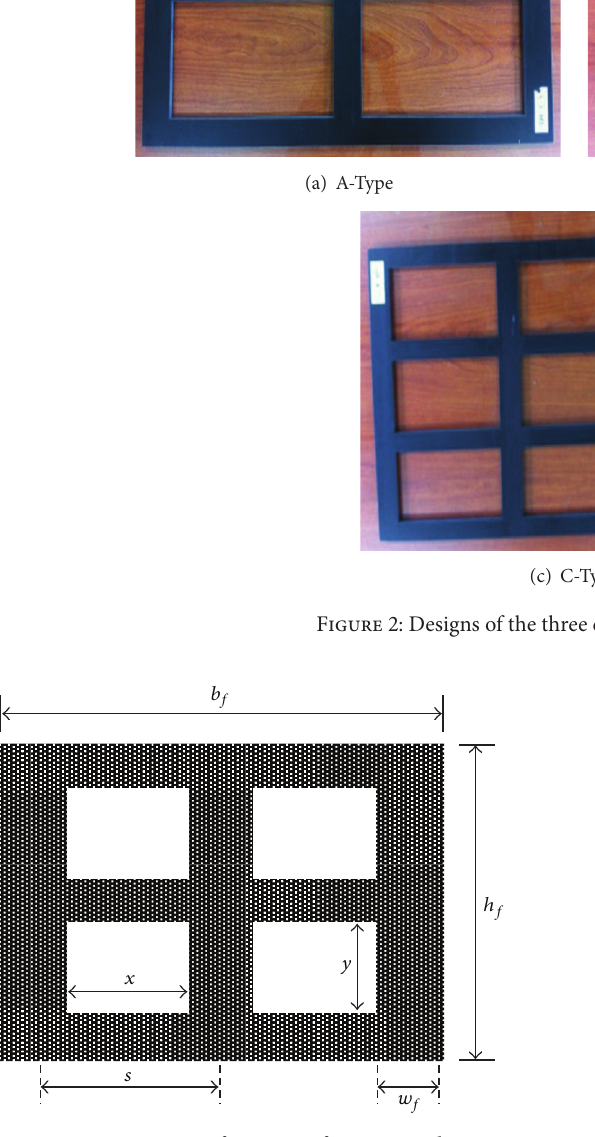
Figure 3: Notation of geometry for a GFRP plate. components ( 𝑛 ), and the tensile strength in the critical shear span, as in (4). The area of the plate ( 𝐴 𝑓 ) can be obtained from (5), and the number of vertical components in the critical shear span can be obtained from